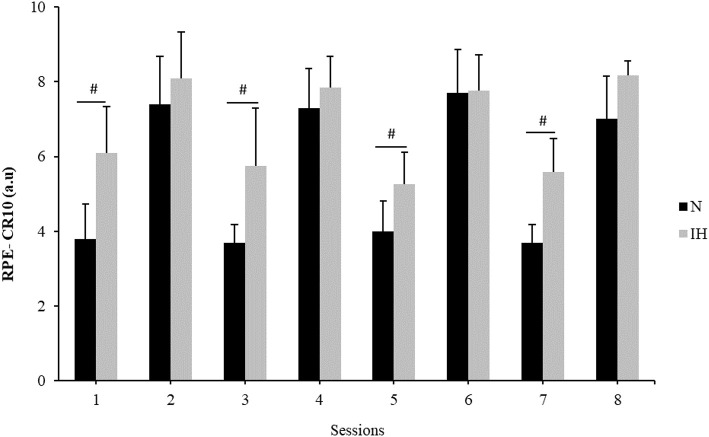
RPE-CR10 (a.u) scores of both groups (IH: , N: ) for each training session. #Significant differences (P < 0.05) were between groups.